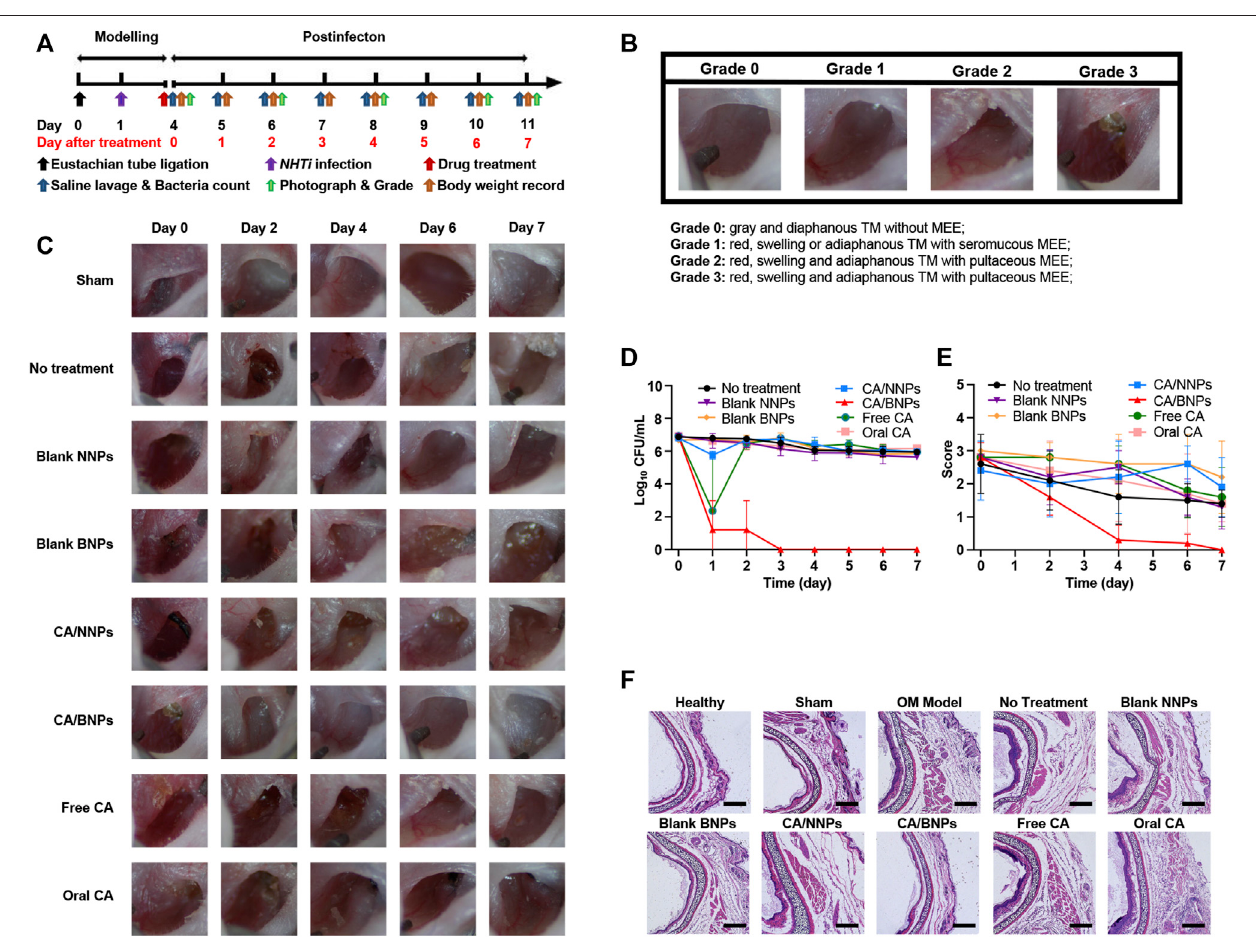
FIGURE 5 | In vivo therapeutic ef fi cacy of CA/BNPs on OM mice. (A) Generation of a NHTi suppurative otitis media mouse model. (model development scheme). The mouse underwent surgery of eustachian tube ligation 1 day before NHTi inoculation. CA/NNPs or CA/BNPs were administrated at day 4 after infection for 3 days. After treatment, the mice were lavaged with physiological saline and monitored via bacterial counting every day. (B) Grading schematic for the establishment of OM in mice. (C) Thephotographsofthemiddleearindifferentgroupsondays0,2,4,6,and7couldobservetheseveritydegreeofmiddleearvisually. (D) Timecourseof bacterial CFU from middle earirrigationsolutionfrom mouse withOMfrom NTHi treated withsaline, blankNNPs, blankBNPs,CA/NNPs,CA/BNPs, freeCA, ororal CA. Data are means ± SD ( n = 5). (E) The score of the middle ear. Data are means ± SD ( n = 5). (F) H&E-stained cross sections of the middle ear after different treatment for 7 days. Scale bar: 200 nm (magni fi cation = ×10). These images are representative of the middle ear sections from n = 5 mice for each